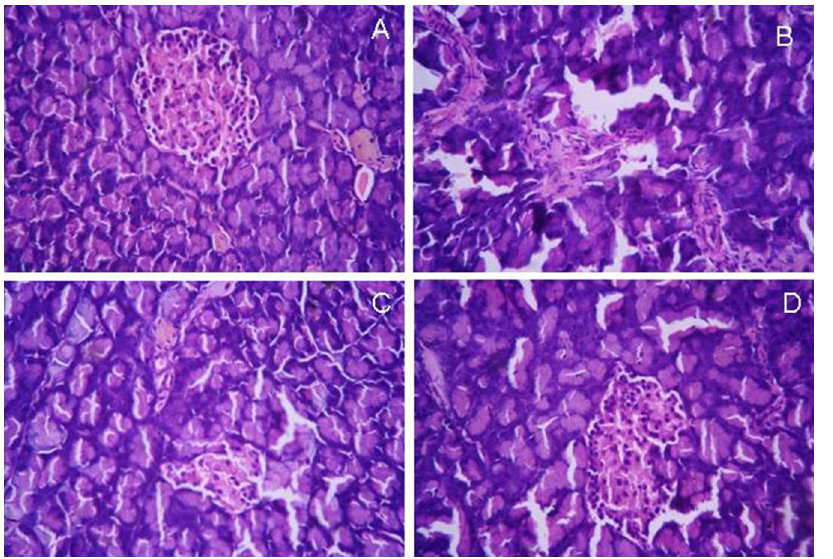
Figure 10. Histopathology examination of pancreas sections. (A) Normal Pancreas, (B) Diabetic Pancreas, (C) Sb treated pancreas, (C) CSbnp treated pancreas (Magnification 100 6 ). Representative micrographs are shown.